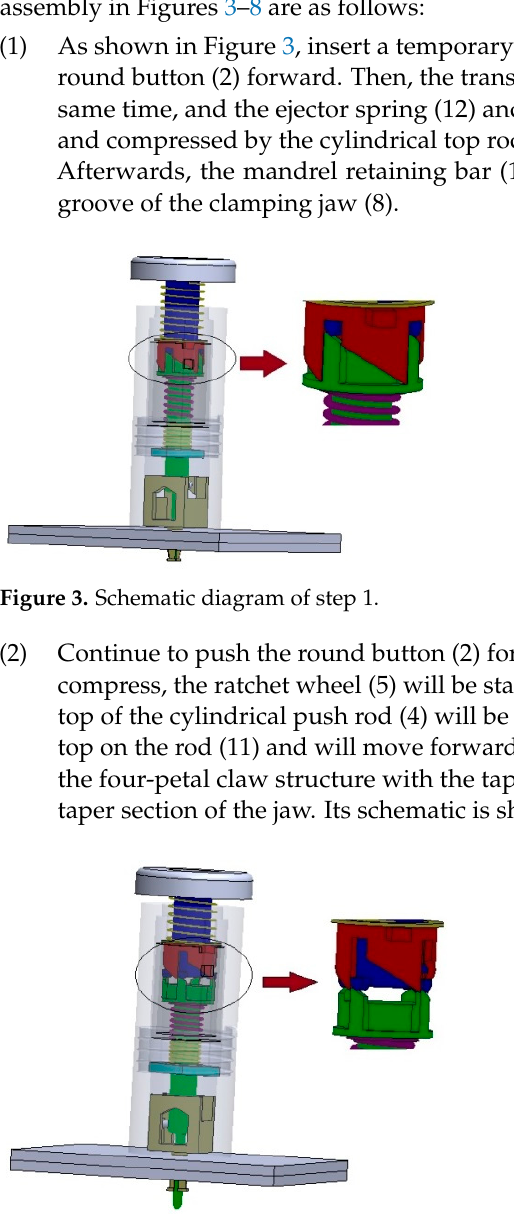
Figure 4. Schematic diagram of step 2.